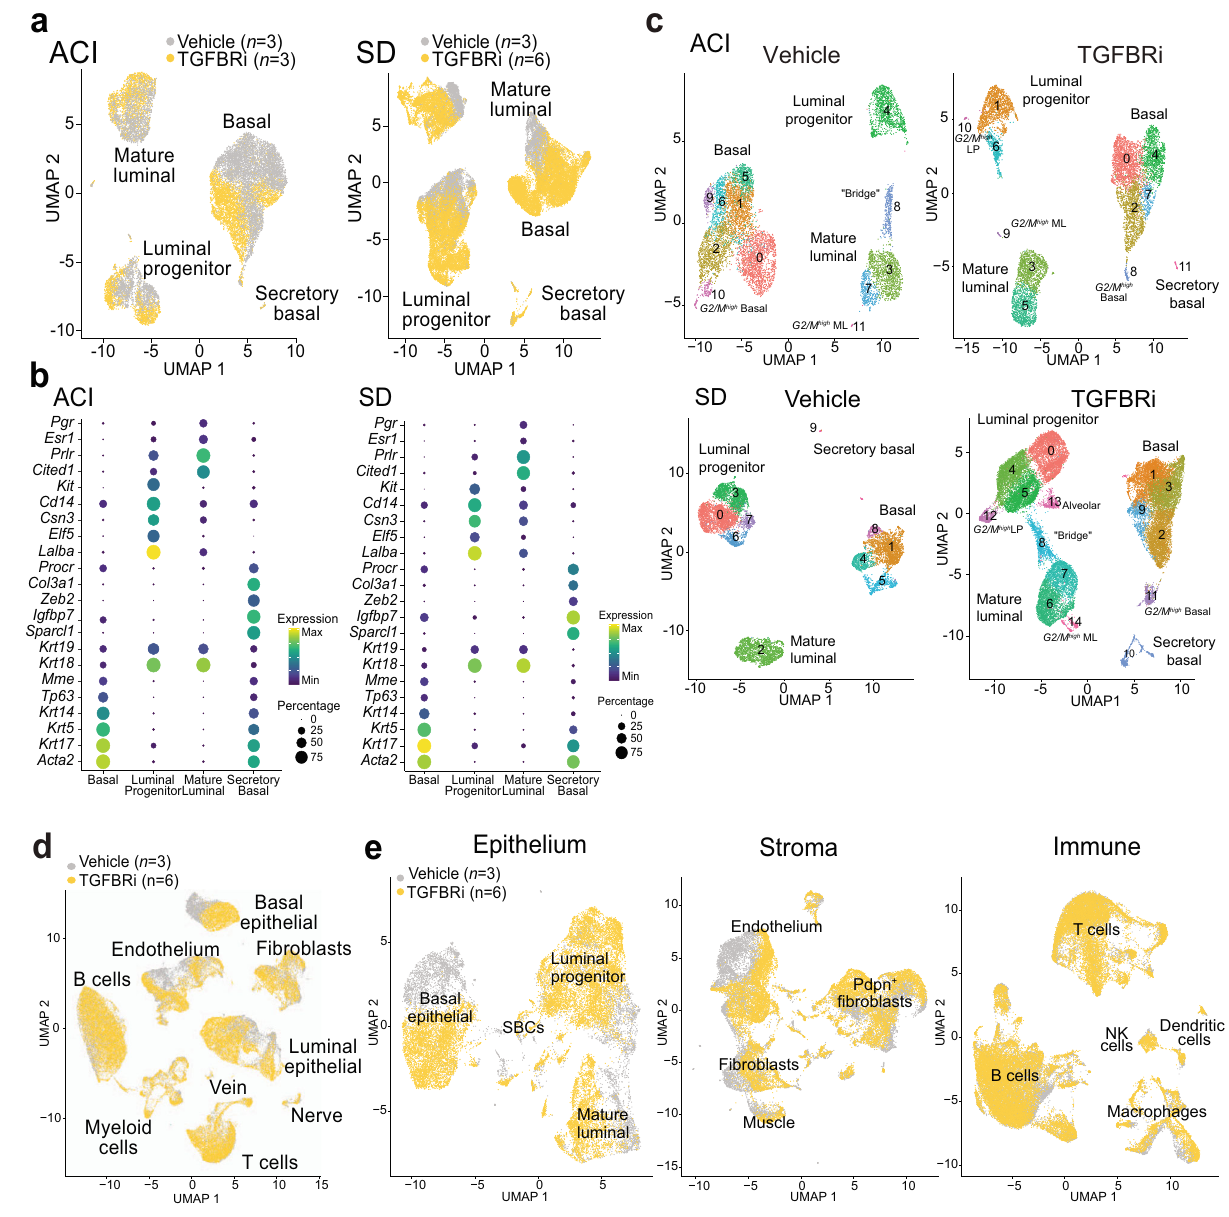
Fig. 3 | Single-cell RNA-sequencing analysis of mammary epithelial cell popu- lations. a , b UMAP plots ( a ) and dot plots ( b ) of sorted basal (CD24 + CD29 high ) and luminal (CD24 + CD29 low ) mammary epithelial cell fractions from ACI and SD rats treated with vehicle and TGFBRi. Dot plots show the expression of markers representative of the four identi fi ed cell types. c Integrated UMAP plots of all cells